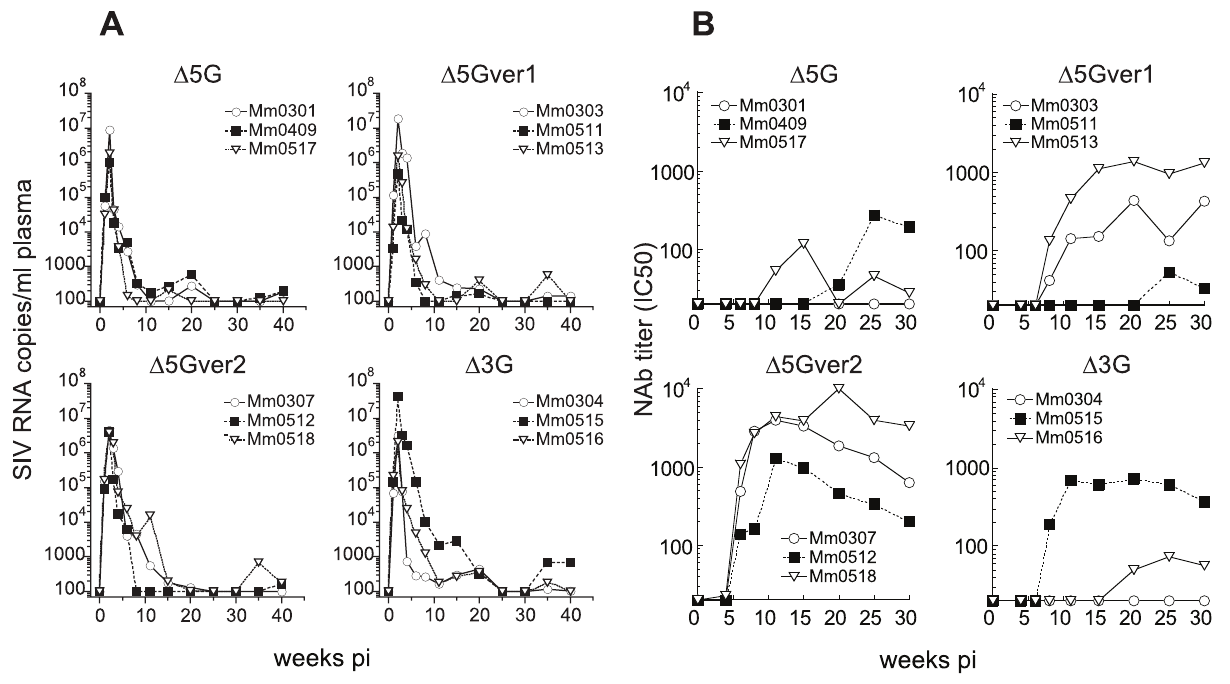
Figure 2. Viral loads and neutralizing antibodies in macaques infected with each of 4 deglycosylated SIV mutants. Twelve animals were divided into 4 groups consist of 3 animals each and infected with each of 4 deglycosylation mutants ( D 5G, D 5Gver-1, D 5Gver-2, and D 3G). (A) Plasma viral loads were determined by real-time RT-PCR with SIVmac239 primers and probe set. (B) NAb responses against each respective infecting virus were measured in CEMx174/SIVLTR-SEAP system. NAb titers were indicated as the reciprocal of the dilutions of the plasma from the vaccinees yielding 50% inhibition (IC 50 ).